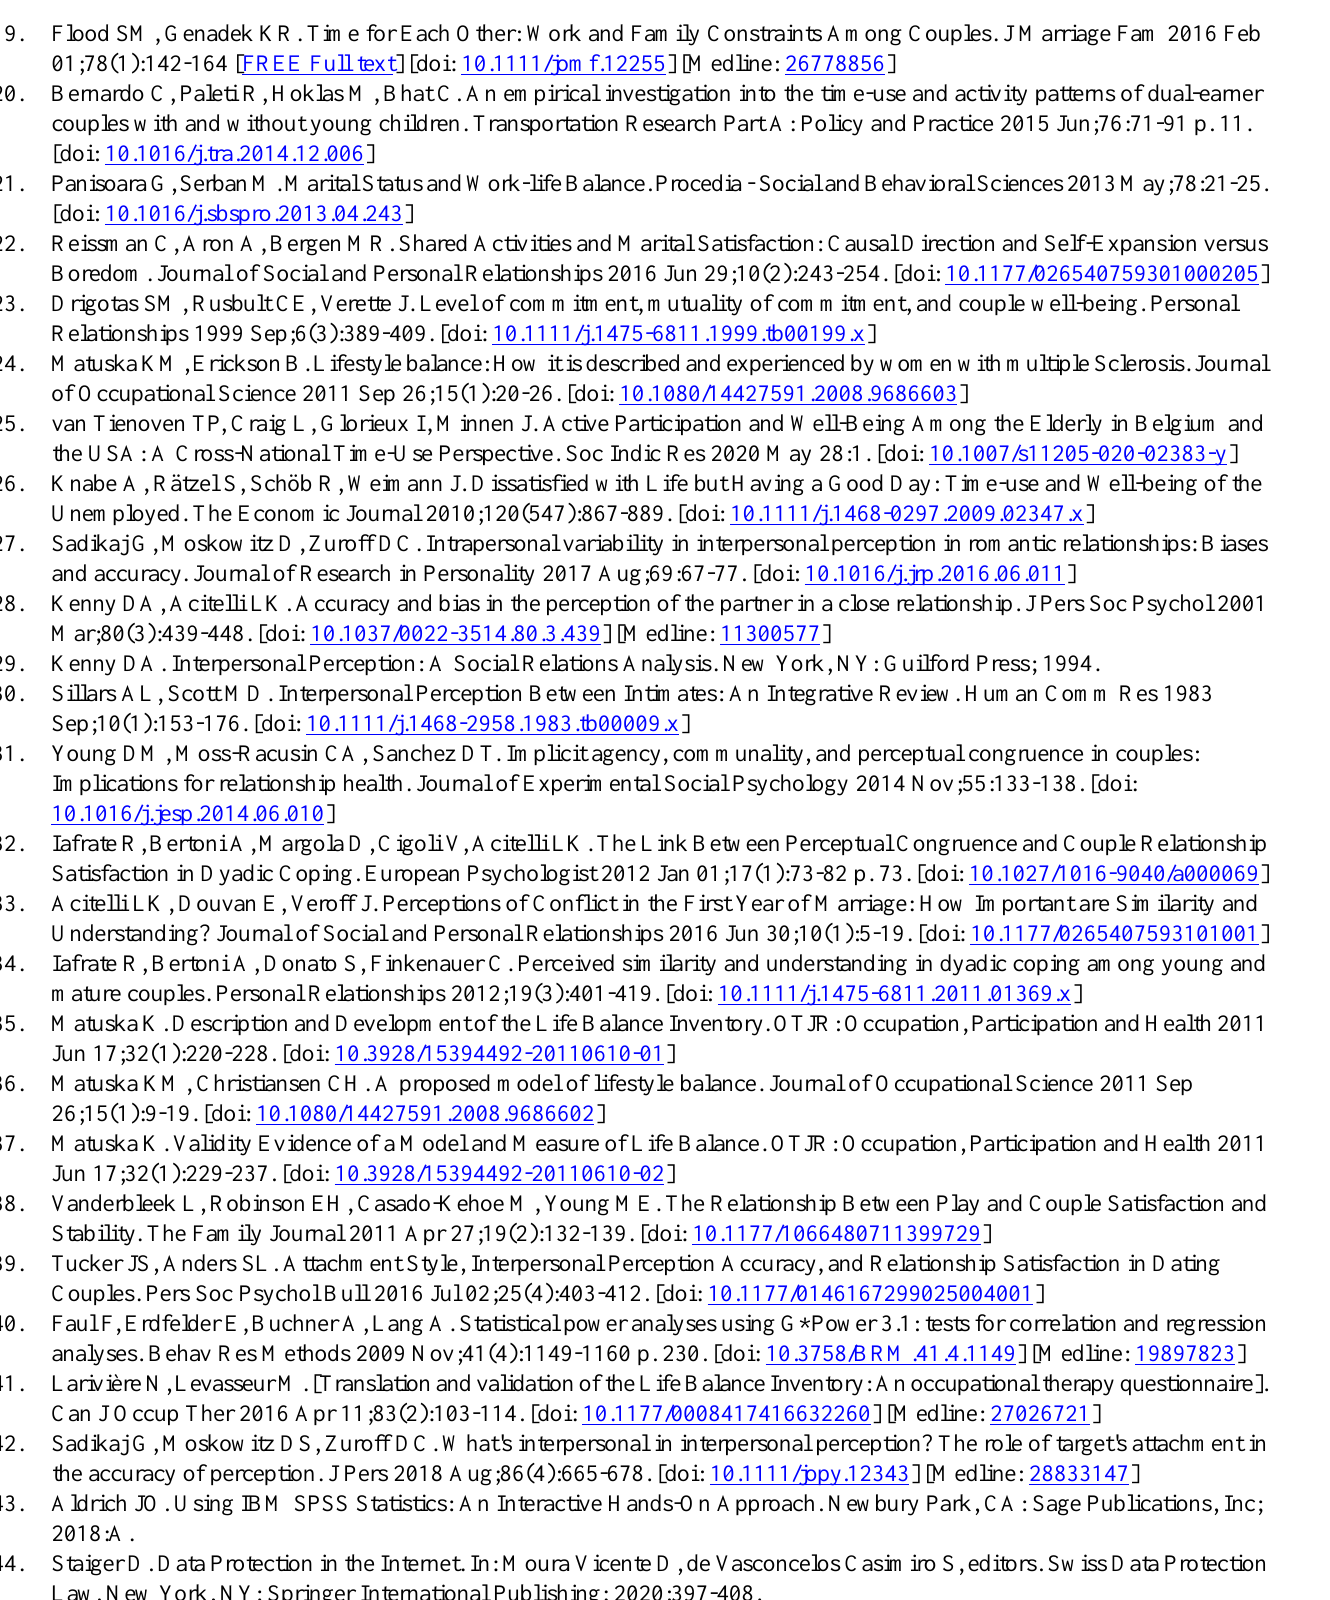
Abbreviations ACC: activity configuration congruence CPA: couple play